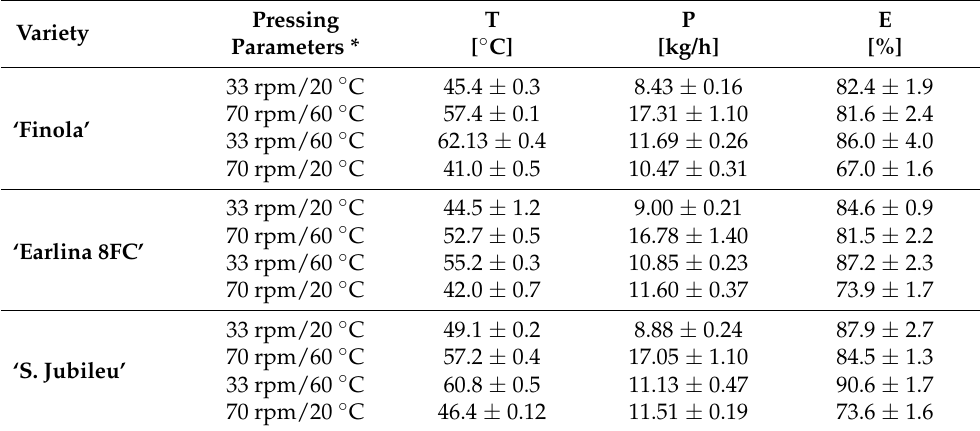
Table 1. Performance and efficiency of the hemp seed pressing process under varying process parameters.